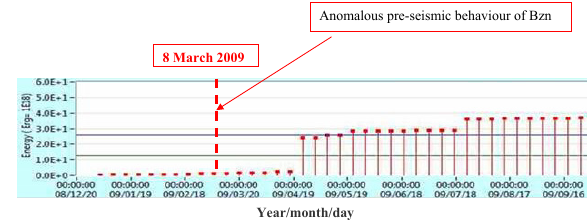
Fig. 8. Variation of earthquake energy in the interval 1 January– 30 September 2009.